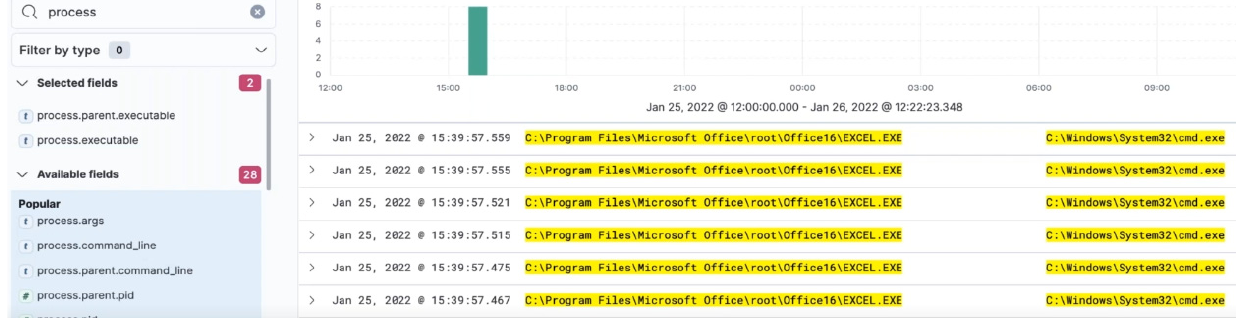
Figure 8. Filtering for process variables.